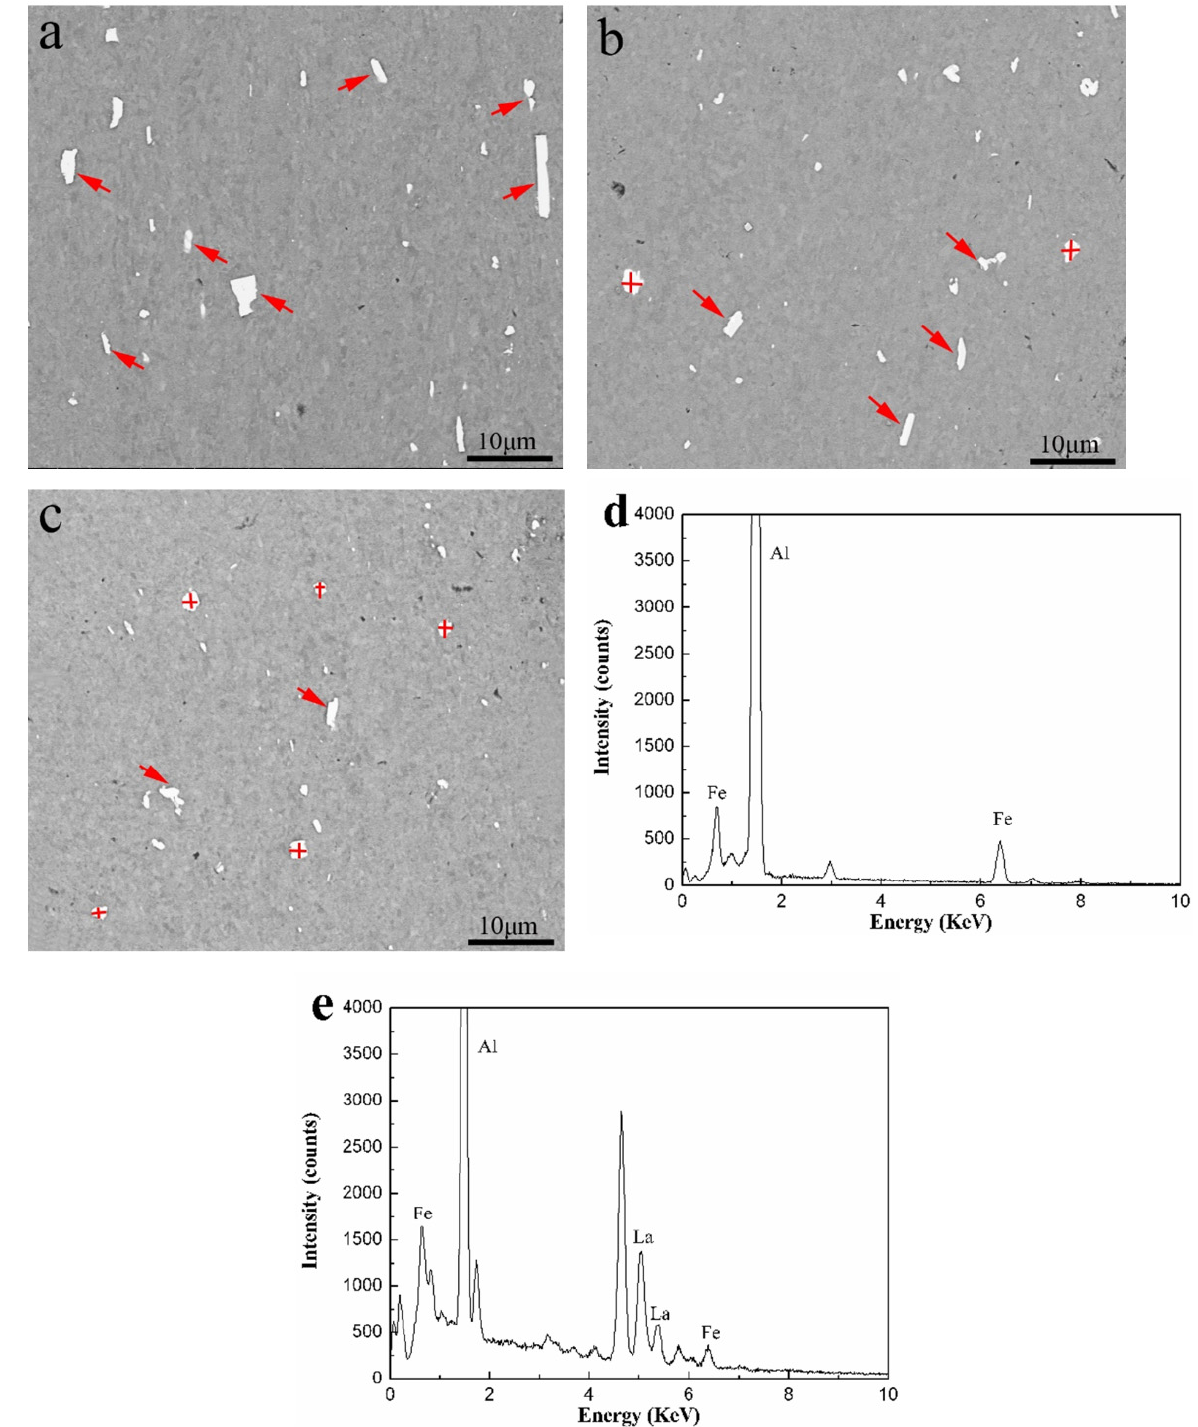
Figure 5. SEM images and energy X-ray spectroscopy patterns of the foil alloys: ( a ) Al-0.2Fe-0.06Cu; ( b ) Al-0.2Fe-0.06Cu-0.1La; ( c ) Al-0.2Fe-0.06Cu-0.15La; ( d , e ) EDS patterns of AlFe phase (arrow mark) and AlFeLa phase (cross mark).